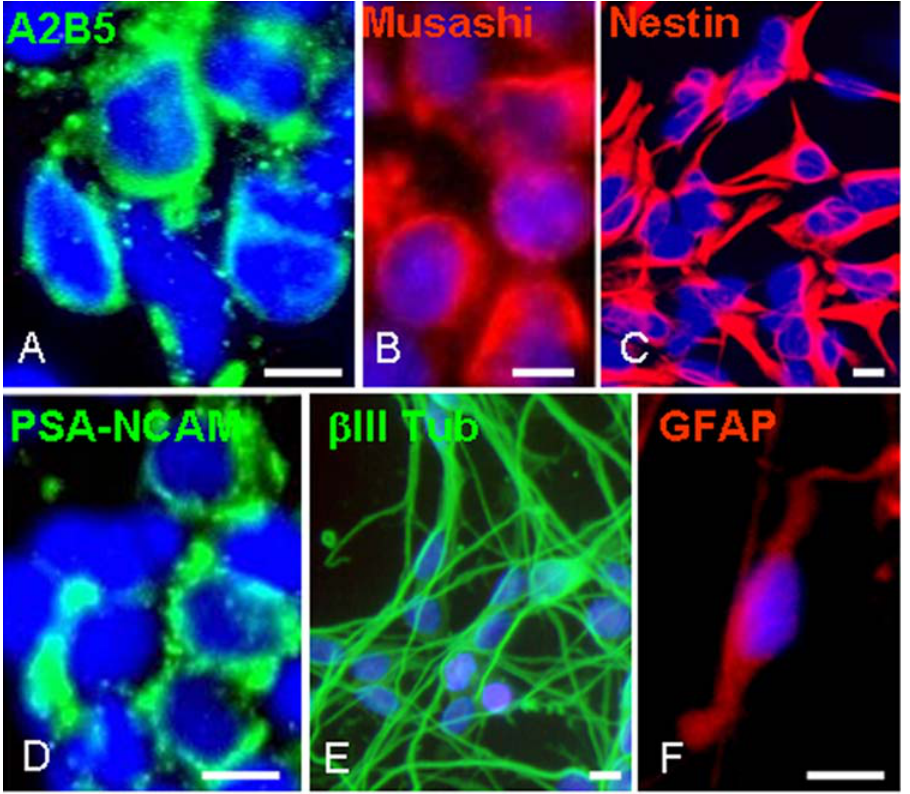
Figure 1. Characterization of the hESC-derived spheres prior to transplantation. Spheres enriched for NPs were developed from hESCs that were cultured for 3 weeks as free floating clusters in serum-free medium supplemented with BFGF, EGF and noggin. The spheres were further expanded for 4–6 weeks in the same medium supplemented with bFGF and EGF before transplantation. For in-vitro characterization spheres were triturated and plated on fibronectin-coated coverslips. Immunofluorescent stainings, 2 hours after plating, demonstrated that the majority of the cells within the spheres were immunoreactive with anti-A2B5 (A), -Musashi (B), -Nestin (C) and -PSA-NCAM (D). To induce differentiation, the plated cells were further cultured 7 days in the absence of mitogens. Immunofluorescent stainings showed that the NPs differentiated mainly into b III tubulin- expressing neurons (E) and GFAP expressing astrocytes (F). Cells expressing oligodendroglial markers were not observed. Nuclei in A–F are counterstained with DAPI (blue). Scale bars: 15 m